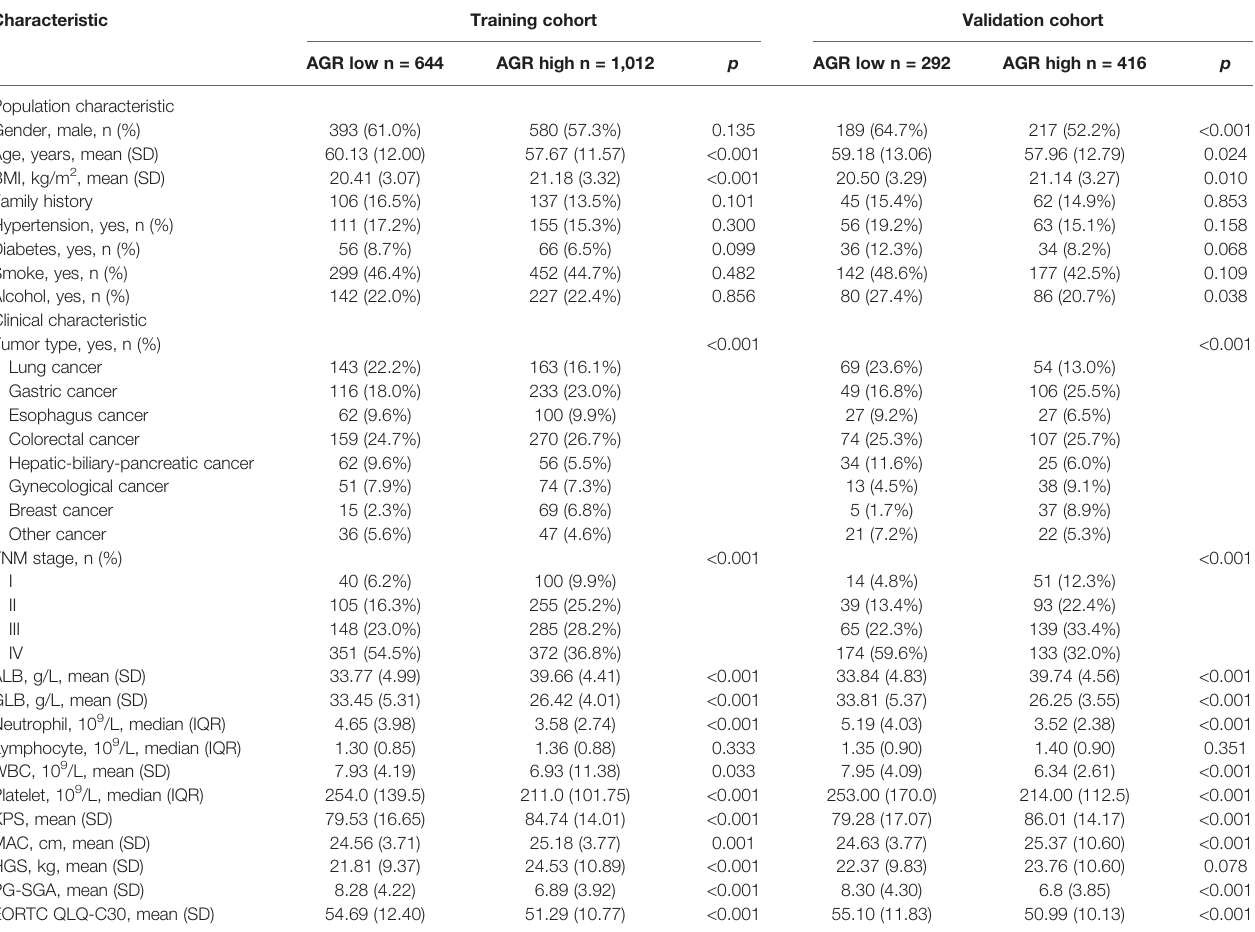
Data are represented as mean [standard deviation (SD)], median [interquartile range (IQR)], or number (%). For AGR, low <1.24; high ≥ 1.24. BMI,body massindex;AGR, albumin – globulinratio; ALB,albumin;GLB,globulin; KPS,KarnofskyPerformance Status;MAC, mid-armcircumference; HGS, handgripstrength; PG-SGA, patient-generated subjective global